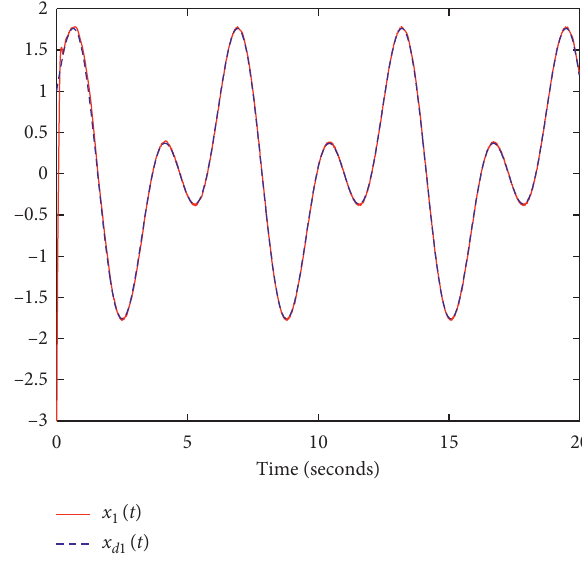
Figure 1: Trajectories of x